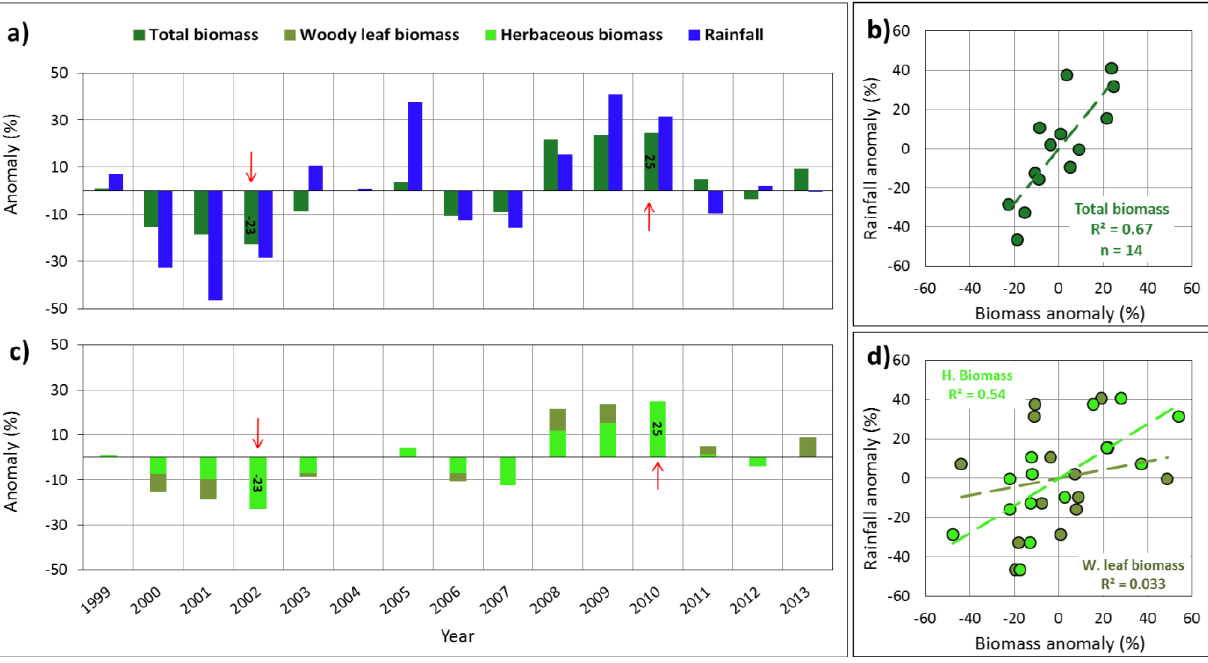
Figure 2. Inter-annual evolution of total biomass and rainfall anomalies ( a ), and comparison of total biomass ( b ), herbaceous and woody leaf biomass contribution in global anomalies ( c ), and herbaceous and woody leaf biomass ( d ) with annual rainfall anomalies averaged in the dataset between 1999 and 2013 (ground biomass data are missing for 2004). Red arrows in (a) and (c) show the highest total biomass anomalies in the time series ( i.e ., years 2002 and 2010). Note that the relationship between rainfall and biomass is strengthened when woody leaf and herbaceous biomass are added